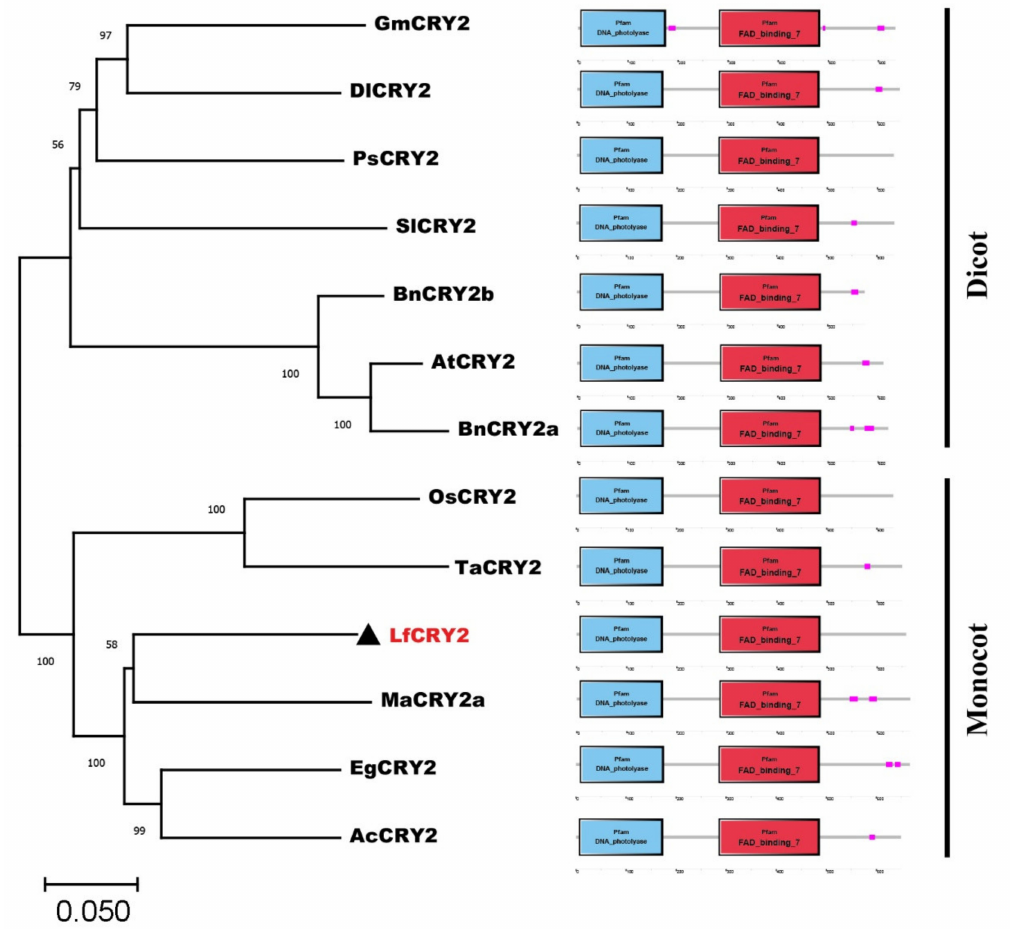
Figure 2. The phylogenetic relationship and conserved domain analysis of CRY2 homologs. CRY2 amino acid sequences from 12 different plant species were acquired from the NCBI database. The phylogenetic tree was generated using the neighbor-joining method. Bootstrap values from 1000 replicates were used to assess the robustness of the tree. The scale indicates the average number of substitutions per site. LfCRY2 is denoted by black triangles. At, Arabidopsis thaliana ; Bn, Brassica napus ; Sl, Solanum lycopersicum ; Ps, Paeonia suffruticosa ; Gm, Glycine max ; Dl, Dimocarpus longan ; Ma, Musa acuminate ; Ac, Ananas comosus ; Ta, Triticum aestivum ; Eg, Elaeis guineensis ; Os, Oryza sativa . The structure diagrams on the right-hand side show the domain structures of the DNA photolyase domain (blue rectangles), and FAD-binding domain (red rectangles) of the CRY2 amino acid